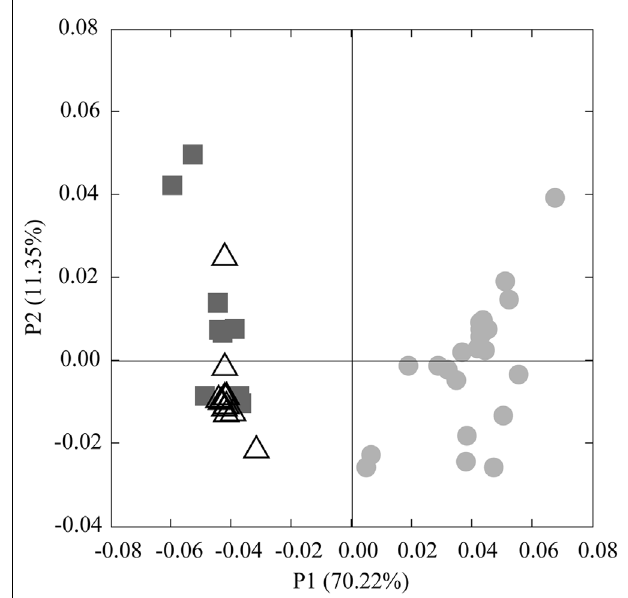
FIGURE 9 | Principal CoordinatesAnalysis (PCoA) ofThaumarchaeota rrs sequences obtained from 40 samples taken in the northern Gulf of Mexico (excluding Station MR1). Shapes indicate sample groupings: dark gray squares, deep, offshore; open triangles, near-surface, offshore; light gray circles, near-surface, inshore.The percentage of the variance explained by an axis is given in parentheses next to the axis